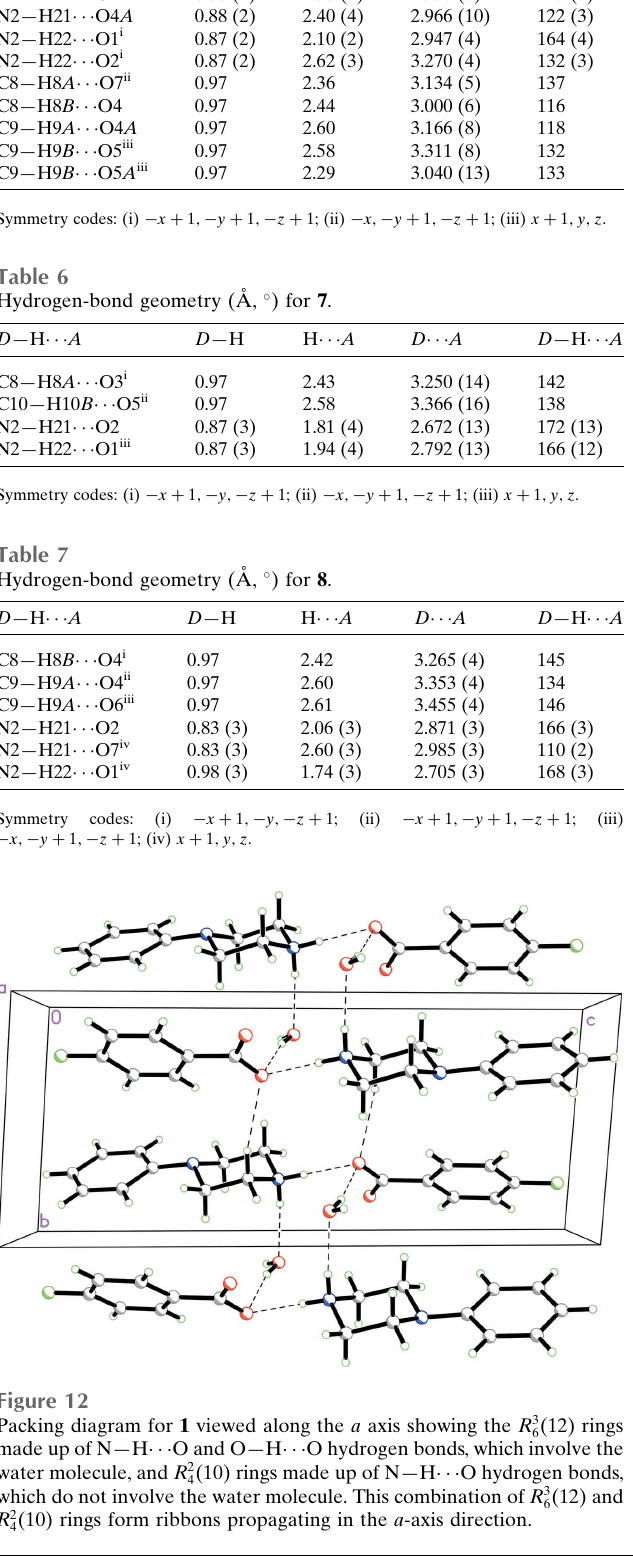
Figure 12 Packing diagram for 1 viewed along the a axis showing the R 3 made up of N—H (cid:2)(cid:2)(cid:2) O and O—H (cid:2)(cid:2)(cid:2) O hydrogen bonds, which involve the water molecule, and R 2 R 2 (10) rings form ribbons propagating in the a -axis direction. 4